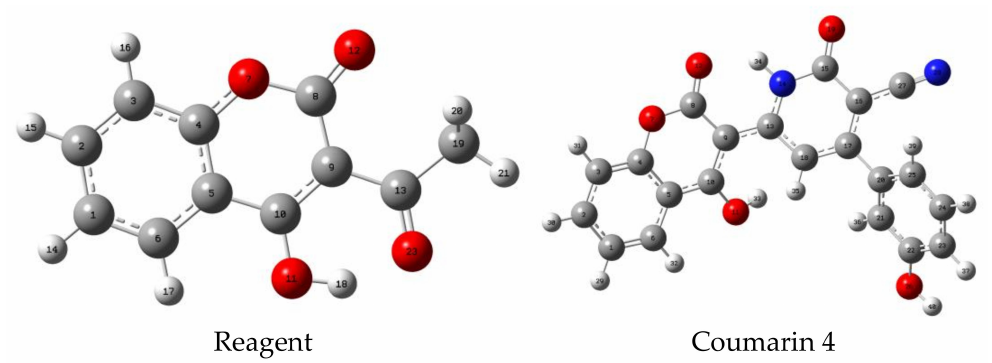
Figure 1. Optimized structure of the reagent and the product (2-amino-4-hydroxy-6-(4-hydroxy-2-